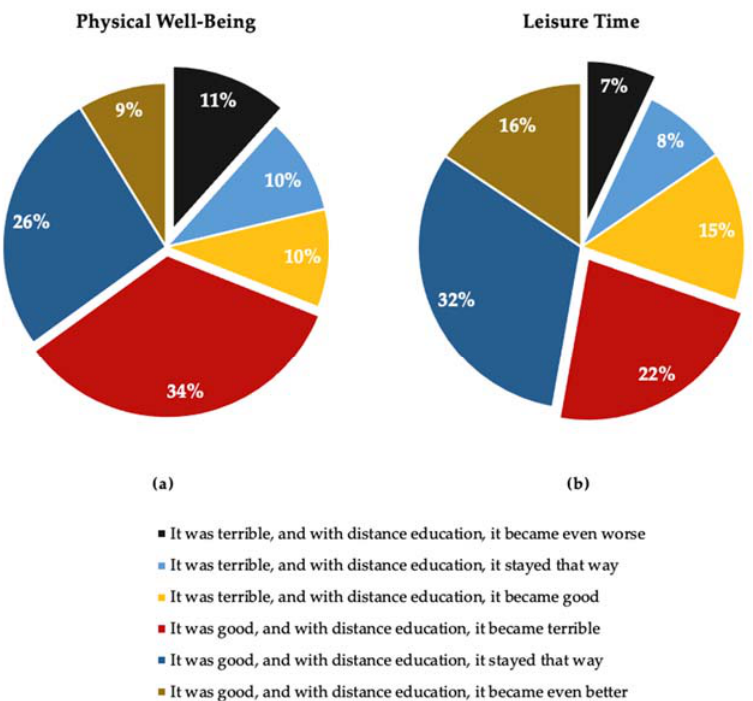
Figure 1. Descriptive results of the study. ( a ) Assessment of physical well-being during the COVID- 19 outbreak in the experiences of Polish students: almost half of the participants declared deteriora- tion in this area (black and maroon parts), and one-fourth did not notice any changes (navy blue). ( b ) Assessment of leisure time spending during the COVID-19 outbreak in the experiences of Polish students: one-third of the participants declared a deterioration here (black and maroon part); at the same time, one-third did not notice any change (navy blue). N = 1955.